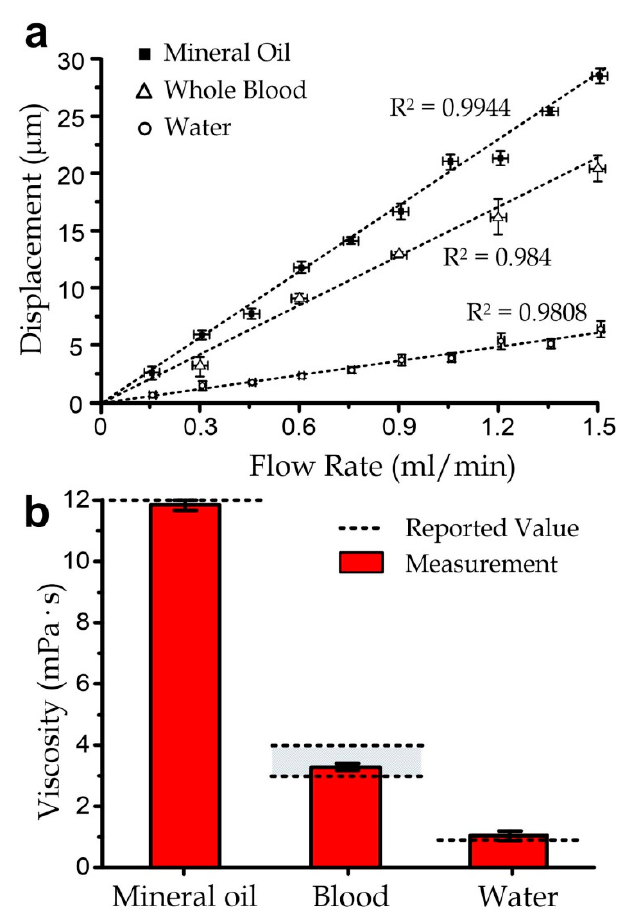
Figure 4. ( a ) Membrane displacement of the microfluidic viscometer as a function of the flow rate under flows of mineral oil, water, and bovine whole blood. ( b ) Resolved viscosity of the measured liquids compared with the reported values from the previous works. All error bars are standard errors of repeated measurements ( N ≥ 5).